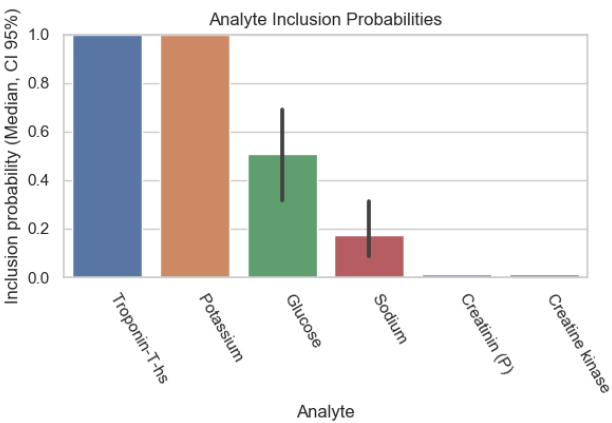
Figure 1. Inclusion probability of parameters based on data subset with initially 20% missing values.